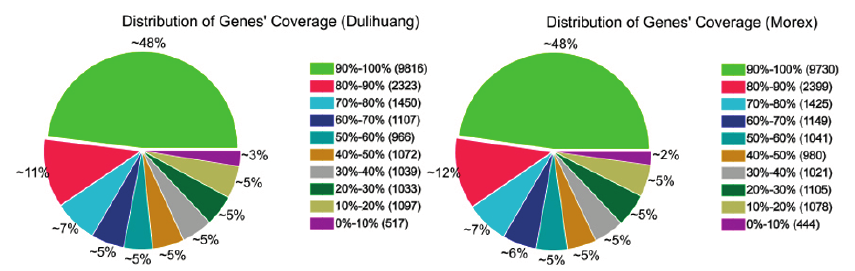
Figure 1. Gene coverage of sample Morex and Dulihuang reads.